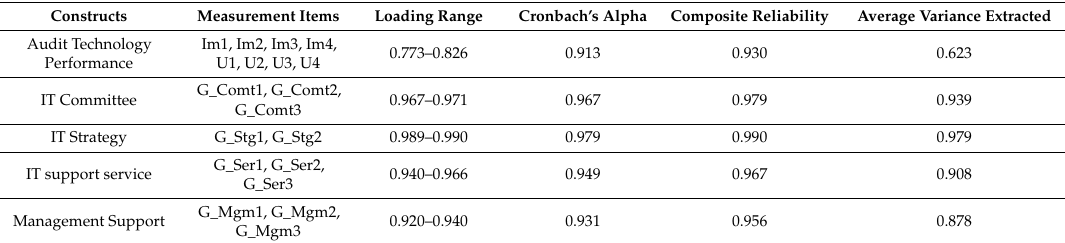
Table 3. Results of the measurement model.